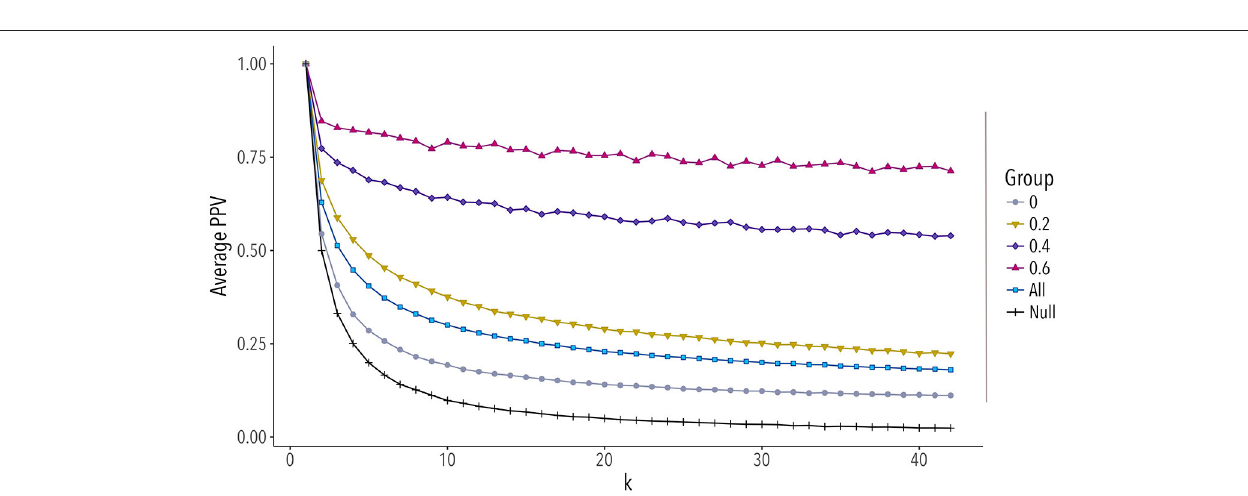
FIGURE 9 | Average PPV(positive predictive values) of the inference mechanism for mentioning relations with a pool of size fr ( u ) × k for different values of average similarity. The All curve presents all the central users irrespectively of their average similarity while the Null represents sets of randomly selected